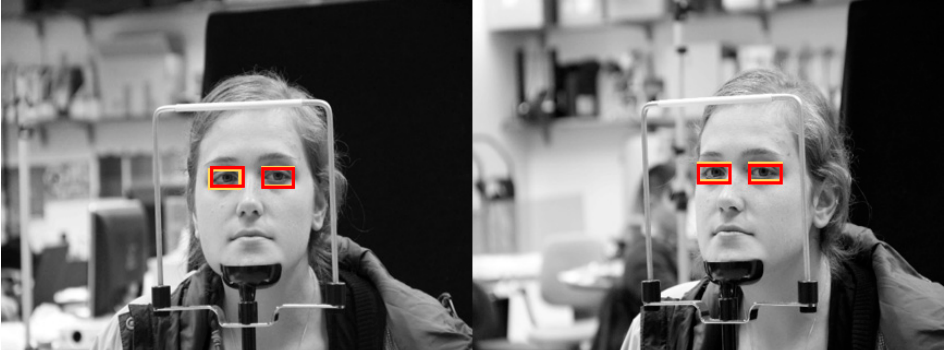
Figure 25. Example of correctly detected eyes by proposed method (Yellow and red rectangles show the ground-truth and detected boxes, respectively).